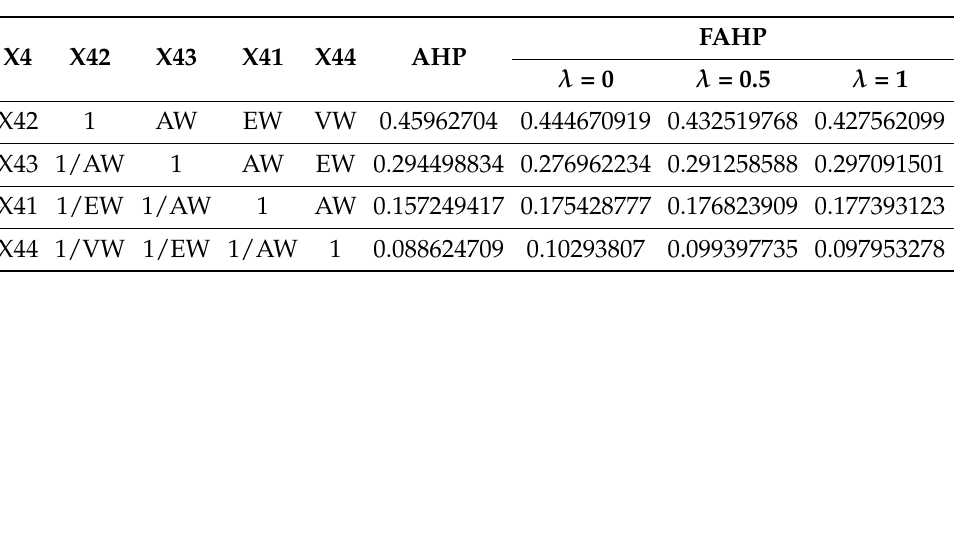
Table 7. Fuzzy comparison matrix for the sub-criteria X4. ( CI = 0.01529, CR =